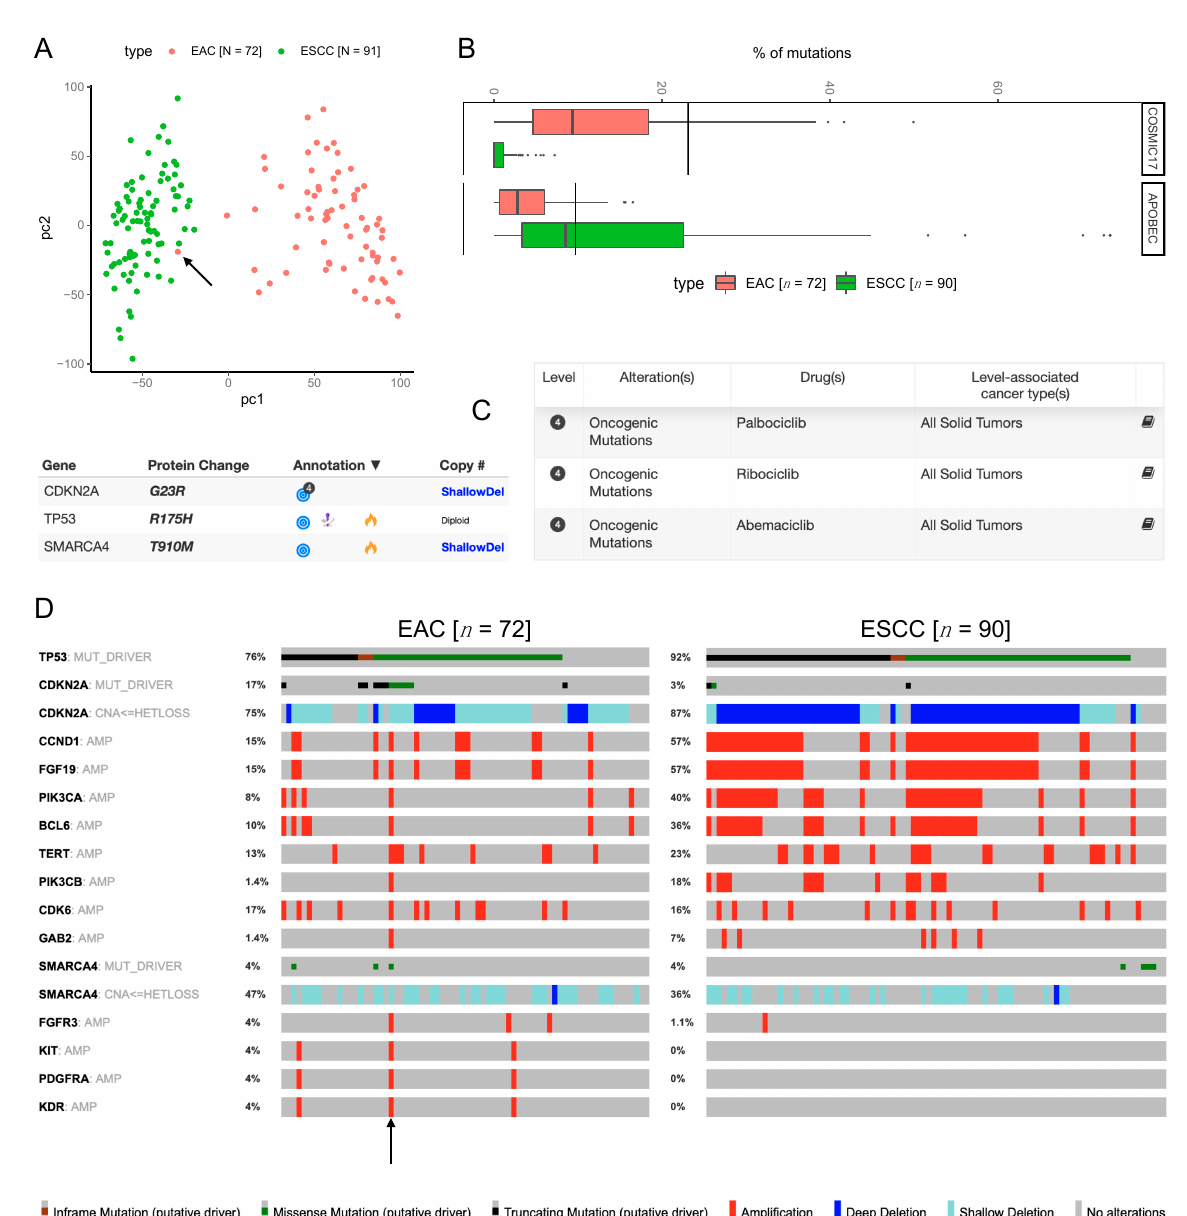
Figure 7. The EAC case comparable to BE cell lines has features of both EAC and ESCC. ( A ) Principal component analysis of gene expression data grouped this case (marked by black arrow) with ESCC cases from TCGA instead of other EAC cases from TCGA. ( B ) As marked by the black lines, this case had a high contribution from COSMIC17 mutation signature (consistent with EAC) and a substantial contribution from APOBEC mutation signatures (more typical of ESCC). ( C ) List of oncogenic mutations in this case included a potentially actionable mutation in CDKN2A. ( D ) The mechanism of CDKN2A loss in this case (marked by black arrow) is more common in EAC but copy number alterations present in this case are more common in